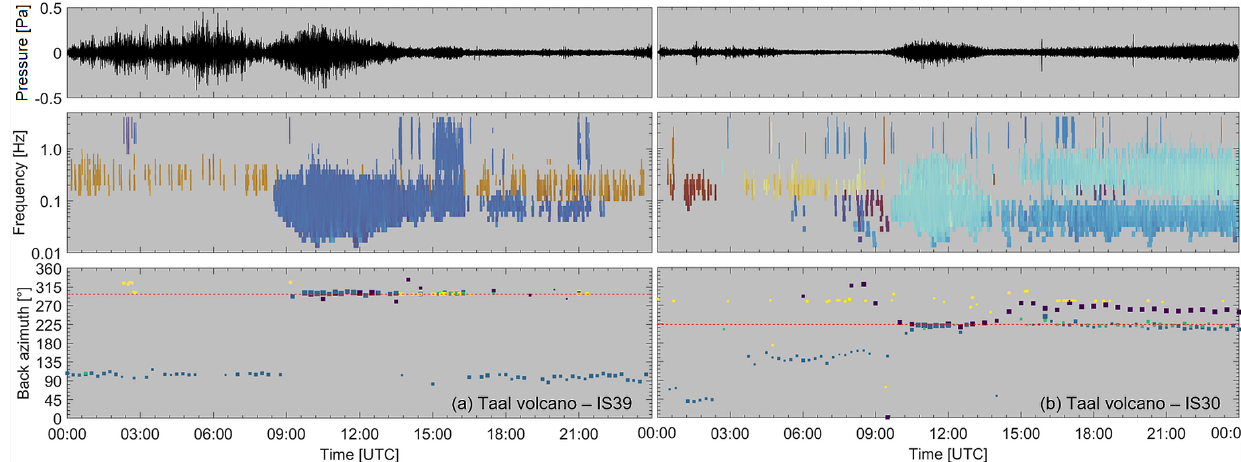
Figure 9. Waveform beam (top), PMCC result (center), and data products of (a) IS39, Palau (1640km distance), and (b) IS30, Japan (3050km), on 12 January 2020, when a strong eruption of the Taal Volcano (the Philippines) occurred. The waveform beams correspond to the theoretical back azimuths and a third-order Chebyshev bandpass filter (0.05–4Hz). The dashed red lines depict the theoretical back azimuths relative to the Taal Volcano. At IS39, the broadband signatures cover all data products. The colors and symbols of Fig. 8 apply.